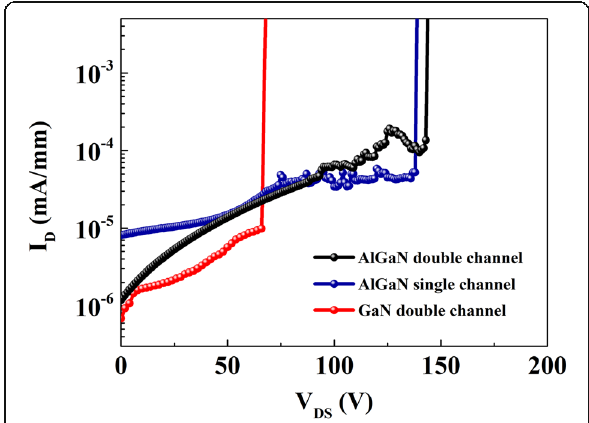
Fig. 7 Breakdown characteristics of AlGaN double channel, AlGaN single channel, and GaN double channel